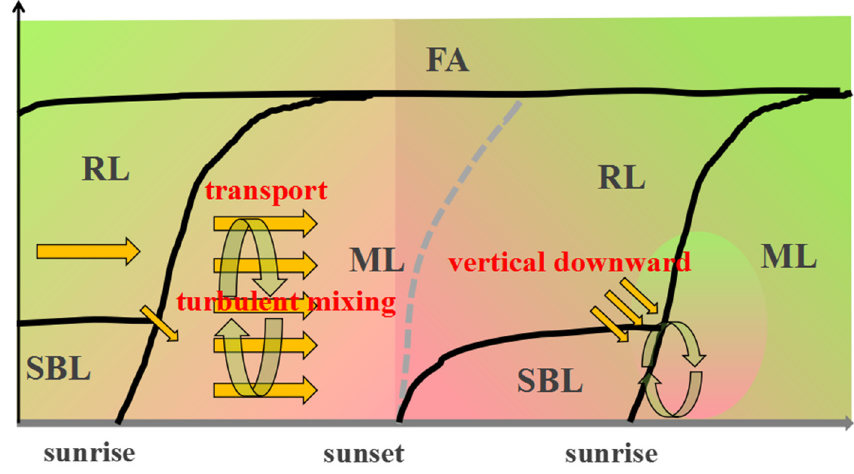
Figure 10. Synergistic mechanism between the regional transport of atmospheric pollutants and the evolution of the ABL. The yellow arrow represents the pollutant transport direction, and circles with arrows represent the vertical mixing effect.